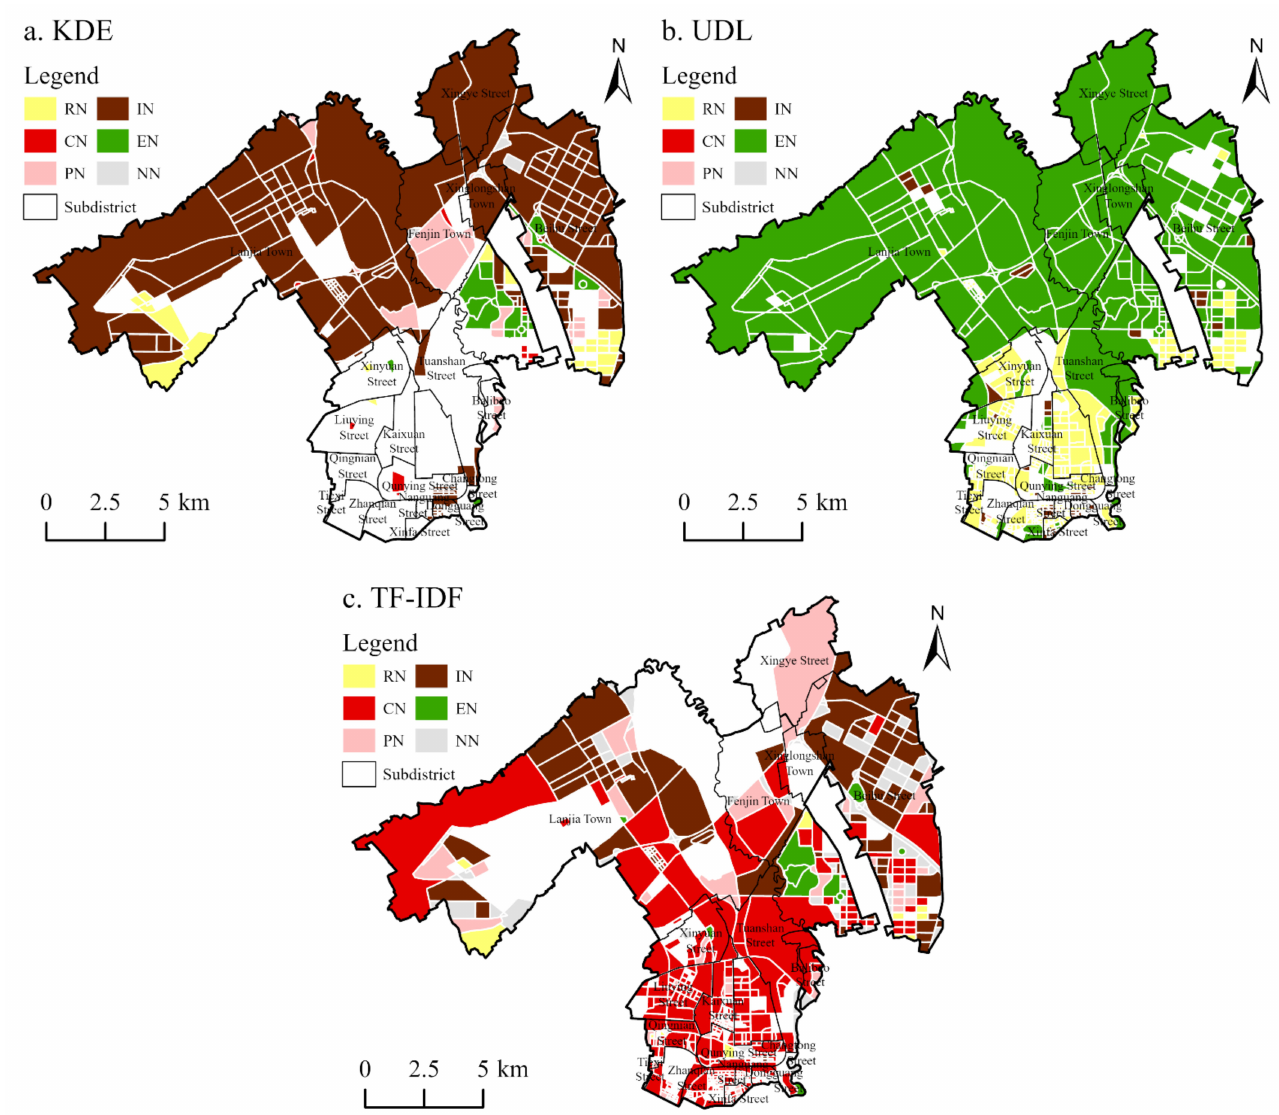
Figure 4. Spatial distribution of single functional zones in Kuancheng District predicted by ( a ) Size KDE, ( b ) UDL, and ( c ) TF-IDF (RN, residential zone; CN, commercial and commercial services facilities zone; PN, public government and public service zone; IN, industrial and mining storage zone; EN, ecological zone; NN, no data